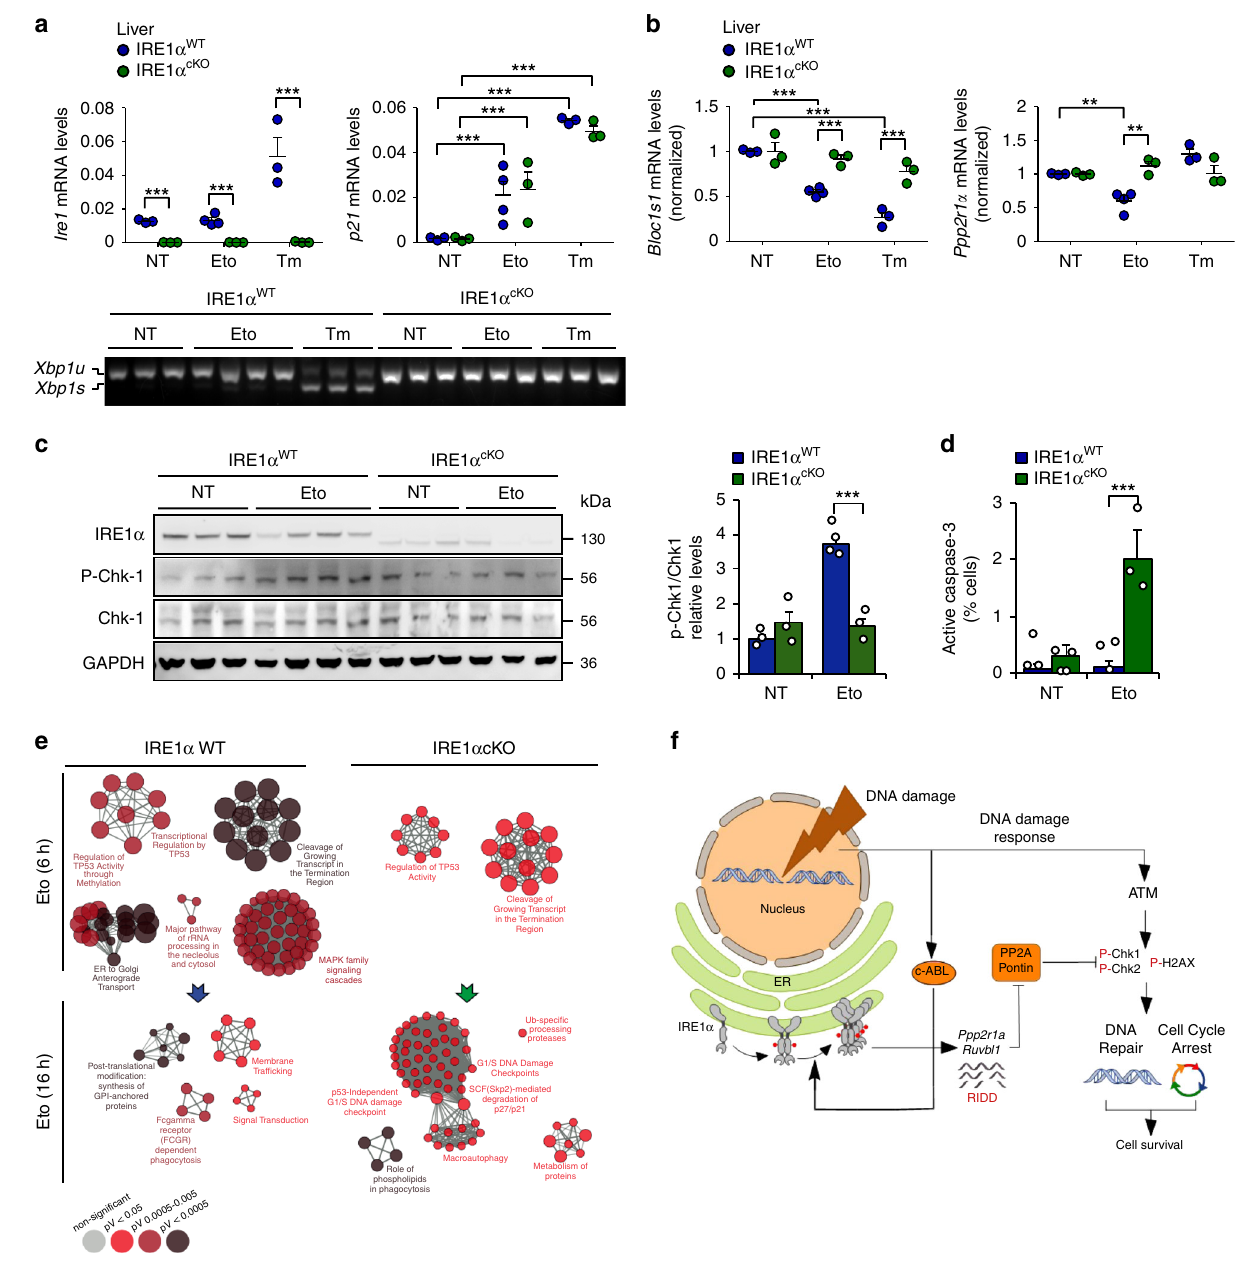
Fig. 6 IRE1 α deletion in liver alters the DDR under genotoxic stress. a IRE1 α was conditionally deleted the liver using the MxCre and LoxP system (IRE1 α cKO ). Mice were intraperitoneally injected with 50 mg/Kg etoposide (Eto) or 1 mg/Kg tunicamycin (Tm) and sacri fi ced 6 h and 16 h later. Total mRNA levels of the deleted IRE1 , and p21 were measured 6 h later in the liver by real-time-PCR ( n = 3 – 4 mice per group). Xbp1 mRNA splicing (bottom panel) was monitored in the same samples by RT-PCR. b Liver extracts of animals described in a , Ppp2r1a and Bloc1s1 mRNA expression levels were measured 6 h later of Eto treatment by real-time-PCR ( n = 3). c Protein liver extracts were obtained from mice treated described in a and the expression levels of indicated proteins were monitored 6 h later of Eto treatment by western blot. Quanti fi cation of the levels of p-CHK1 is shown (Right panel). d Mice from a were intraperitoneally injected with 50 mg/Kg Eto and sacri fi ced 48 h later. Then, livers active-caspase 3 detected by immunohistochemistry ( n = 2 – 3). e Gene expression pro fi le analysis was performed in mRNA from liver extracts of animals described in a . Most signi fi cant pathways altered by Eto administration in WT and IRE1 α null livers are shown. Three independent biological samples were used. In all panels, data is shown as mean ± s.e.m.; * p < 0.05, ** p < 0.01, and *** p < 0.001, based on a – d two-way ANOVA followed Bonferroni ’ s test. Data is provided as a Source Data fi le. f Working model: genotoxic stress activates IRE1 α in the absence of ER stress markers, selectively engaging RIDD. IRE1 α degrades mRNAs involved in the DNA damage response encoding for Ppp2r1a and Ruvbl1 , regulating the (de)phosphorylation of the histone H2AX and CHK-1/2. The non-canonical activation of IRE1 α involves the participation of the c-Abl kinase that is activated by DNA damage response kinases as ATM. The expression and function of IRE1 α is essential to promote survival under DNA damage conditions by controlling cell cycle arrest and DNA repair